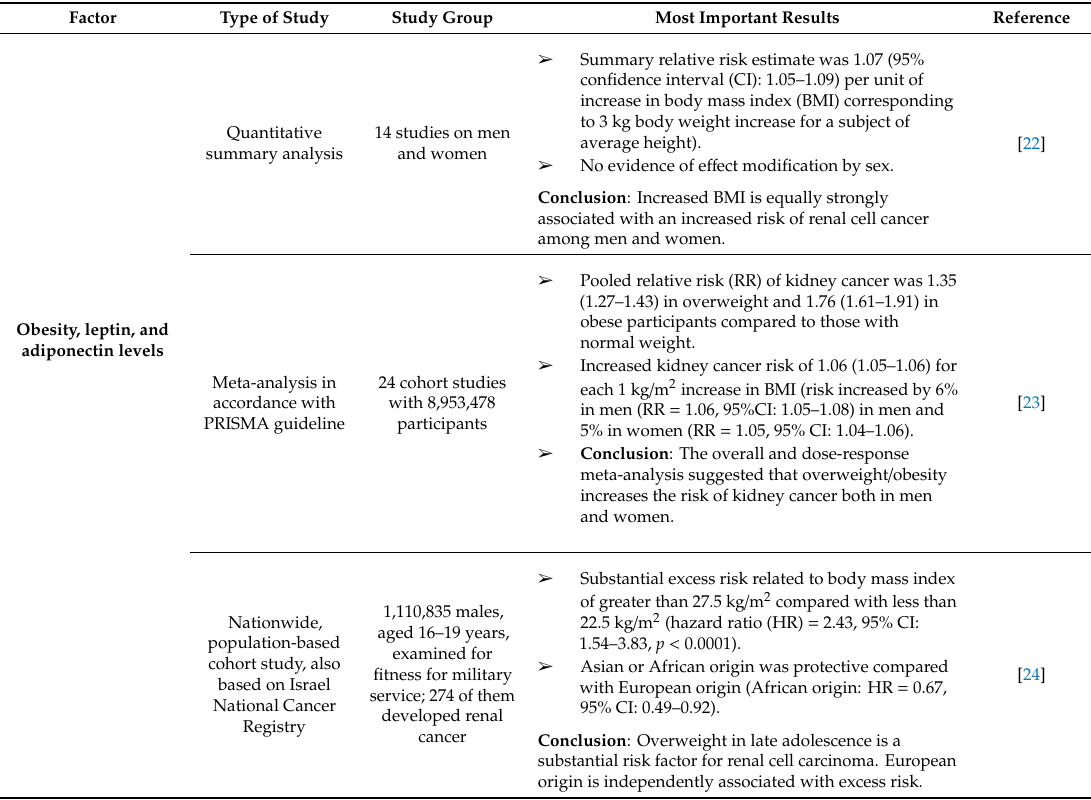
Table 1. The summary of most important studies included in this